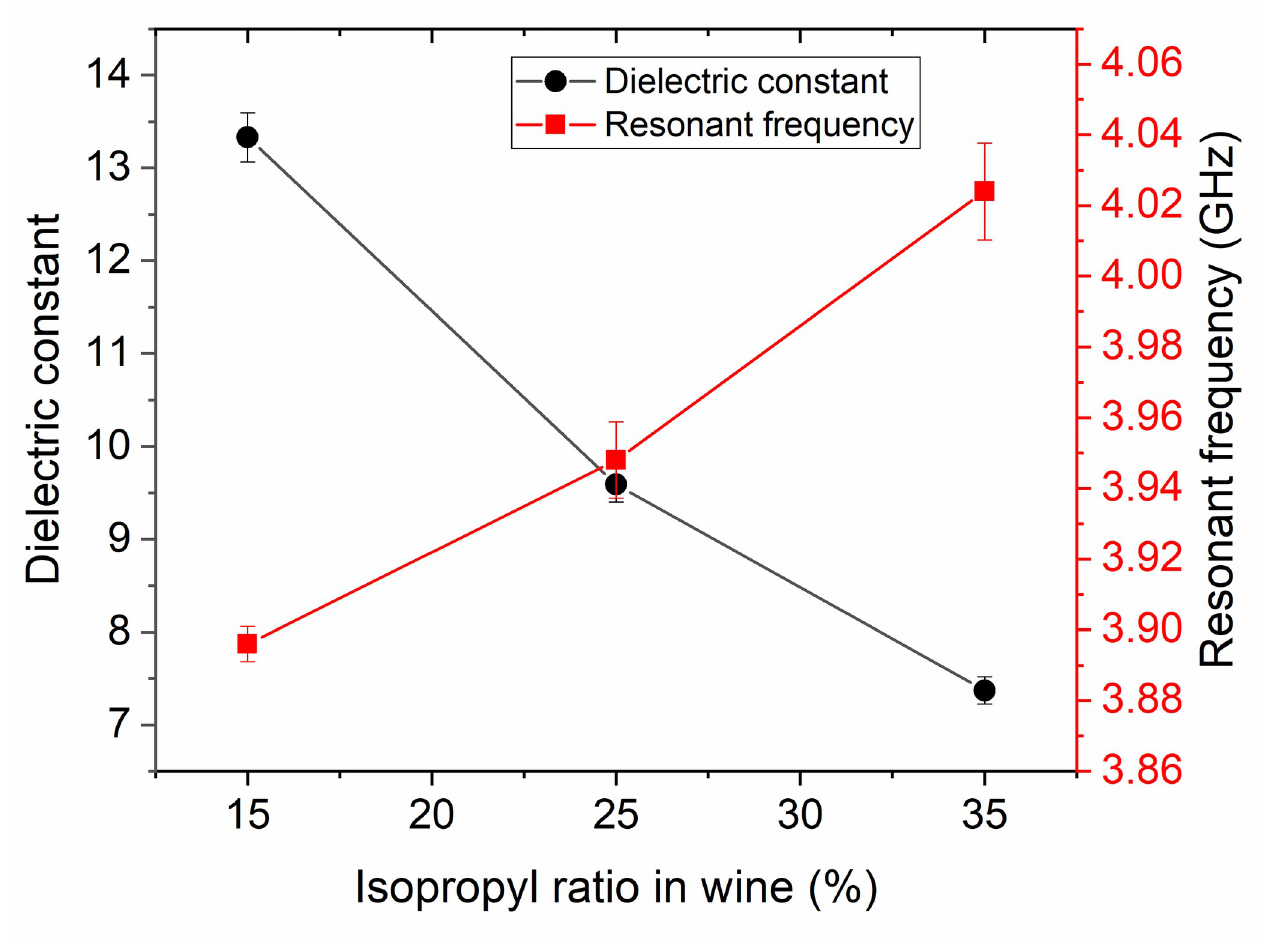
Fig 10. Variations of the resonant frequency with isopropyl alcohol content detected by the proposed antenna sensor